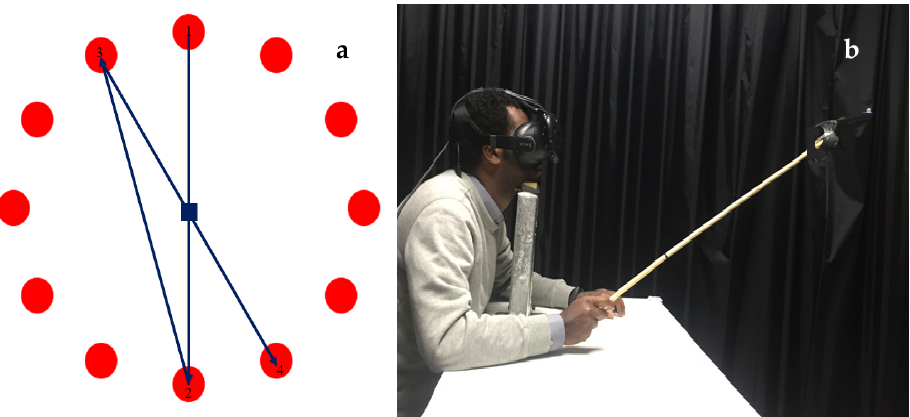
Figure 2. Illustration of ( a ) experimental task (a combination of twelve pointing trials) and the steps of reaching for the very first four targets and ( b ) a pointing posture of a participant in the HMD condition.